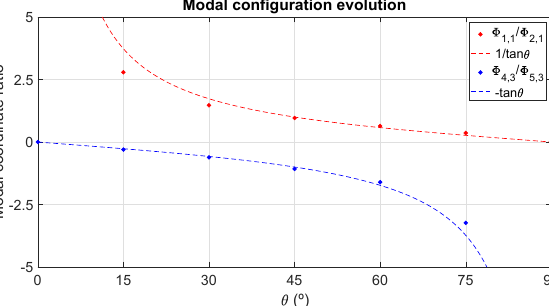
Figure 5. Relation between surge and sway modal coordinates for the translation mode (in red) and between the pitch and roll modal coordinates for the rotational mode (in